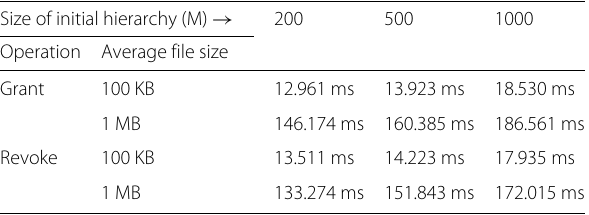
Table 6 Grant and revoke cost in minimal vertex UH Size of initial hierarchy (M) → Operation Average file size